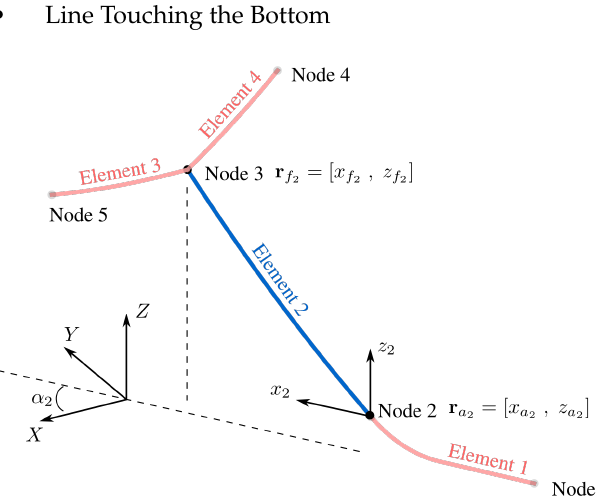
Figure 4. Spatial arrangement of the line